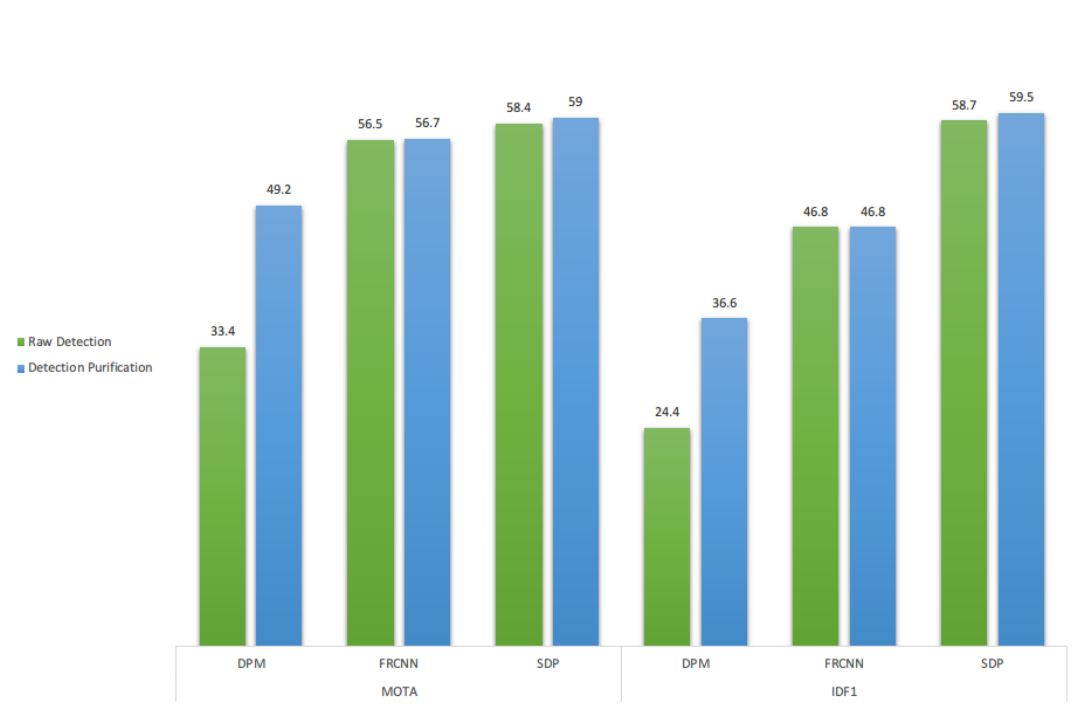
Figure 9. MOTA and IDF1 change after applying detection